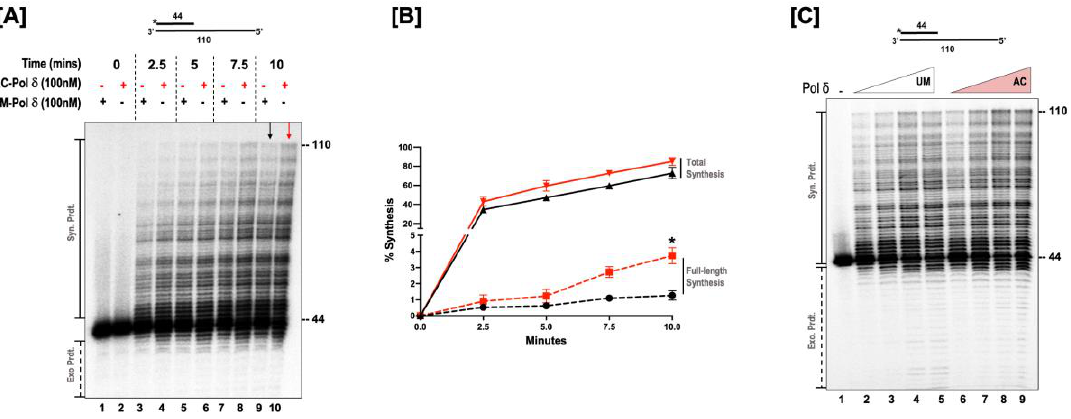
Figure 2. Acetylation enhances the synthesis activity of pol δ . ( A ) The synthesis activity of pol δ was assayed using the 5 nM substrate (U 1 :T 1 ) in the presence of 100 nM of either the unmodified (UM) or acetylated (AC) forms of pol δ . Time-course synthesis assay was monitored at the respective time points (0, 2.5, 5, 7.5, and 10 min) as indicated in the figure and as described in the “Section 2.6”. The substrate is depicted above the gel image, with the asterisk denoting the location of the radiolabel. + indicates the presence and — indicates the absence of the respective forms of pol δ . ( B ) Graphical plot of the percent of synthesis against time in minutes. Dashed red lines represent full-length synthesis by AC-pol δ and dashed black lines represent full-length synthesis by UM-pol δ . Solid red lines represent total synthesis by AC-pol δ and solid black lines represent total synthesis by UM-pol δ . The p value (generated by GraphPad Prism) was calculated by an unpaired, two-tailed t -test, * = p < 0.05. ( C ) Varying concentrations of either acetylated or unmodified pol δ (20, 50, 100, and 200 nM) were assayed for the synthesis activity of both forms of the polymerase. The reactions were set up as described in the “ Section 2.6 ” . The substrate is depicted above each gel image and the asterisk denotes the location of the radiolabel. Exonuclease products (Exo. Prdts.) and synthesis products (Syn. Prdts.) are indicated adjacent to the gel image. The nucleotide sizes are also indicated.